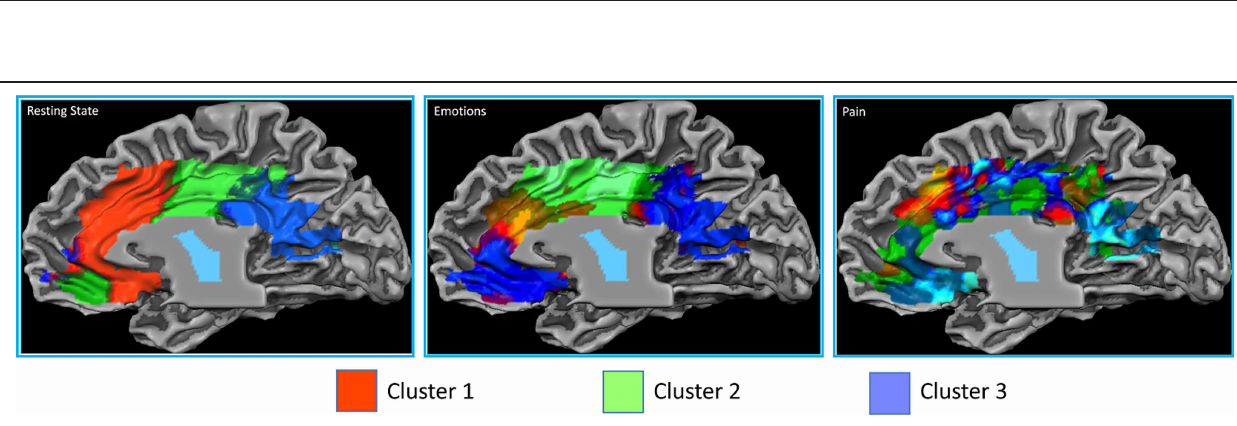
subjects. Maps are projected on an inflated 3D brain surface with the BrainVoyager QX surface tool. This parcellation was obtained by imposing the same number of clusters obtained for the parcellation of the MaC